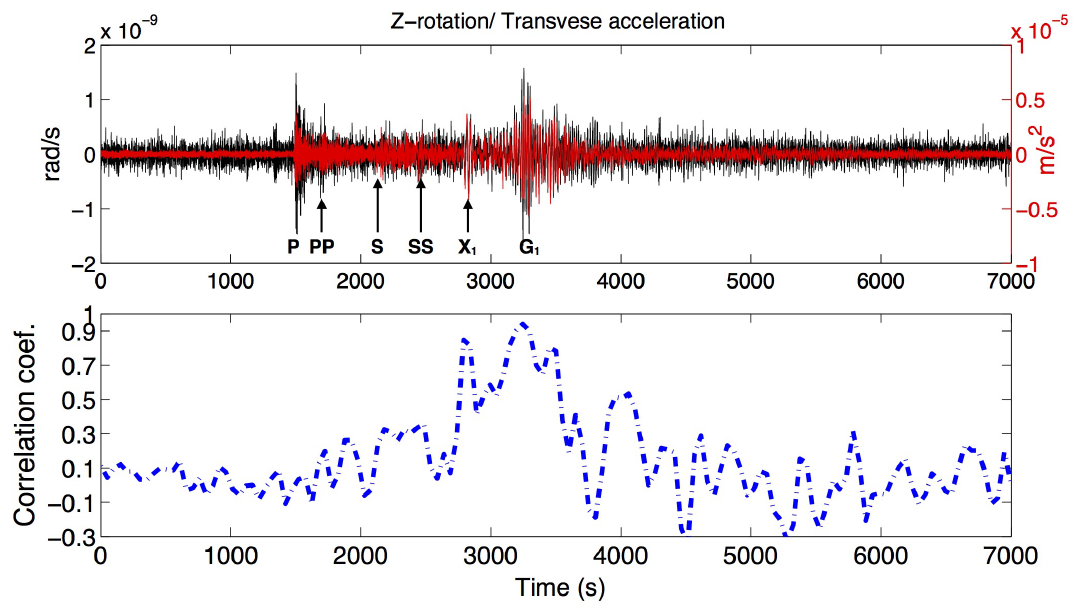
Figure 4: (top) Ground rotation and transverse acceleration time histories (black and red lines, respectively), time zero is at 12:40:00 UTC. (bottom) ZLCC between the above traces.